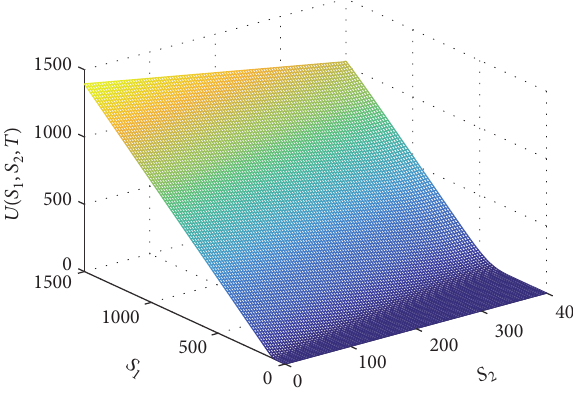
Figure 2: Parameters ℎ and 𝑘 satisfy